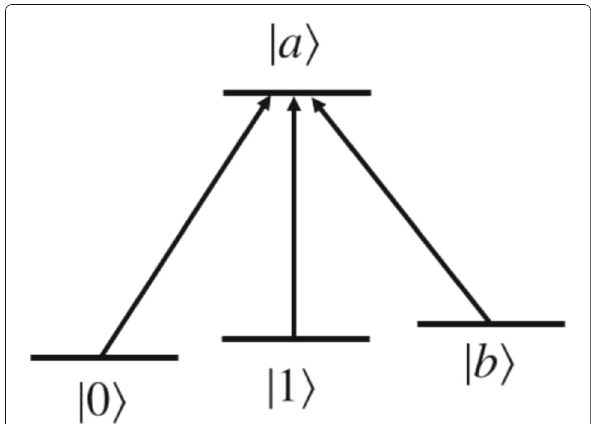
Fig. 1 The level configuration of the four-level connecting system. Two lower levels of the system are used as logical states | 0 (cid:4) and | 1 (cid:4) . The other two are used as auxiliary states | a (cid:4) and | b (cid:4) . For the system, the transitions between states | 0 (cid:4) ↔ | a (cid:4) , | 1 (cid:4) ↔ | a (cid:4) , and | b (cid:4) ↔ | a (cid:4) are allowed to be separately driven by laser